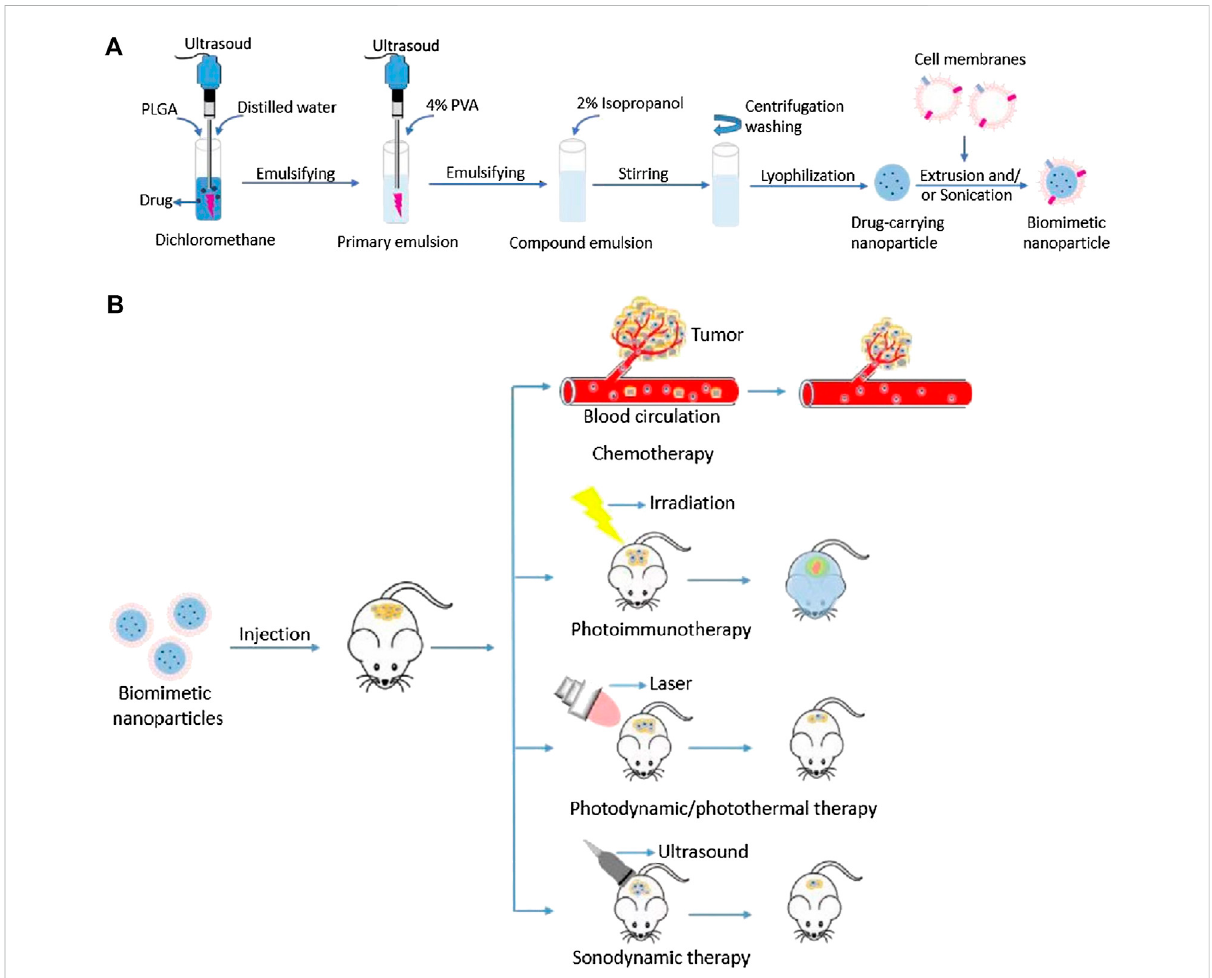
FIGURE 1 (A) Schematic illustration of fabrication processes of cell membrane-camou fl aged drug loaded PLGA nanoparticles; (B) Schematic illustration of the potential anticancer therapies of cell membrane-camou fl aged biomimetic nanoparticles. PLGA: Poly (lactic-co-glycolic